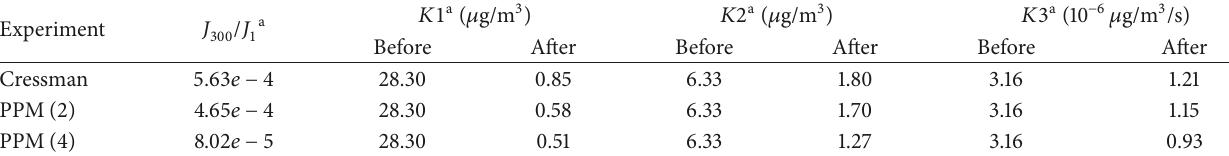
Table 4: The MAEs statistics before and after assimilation, with 37 observation points.